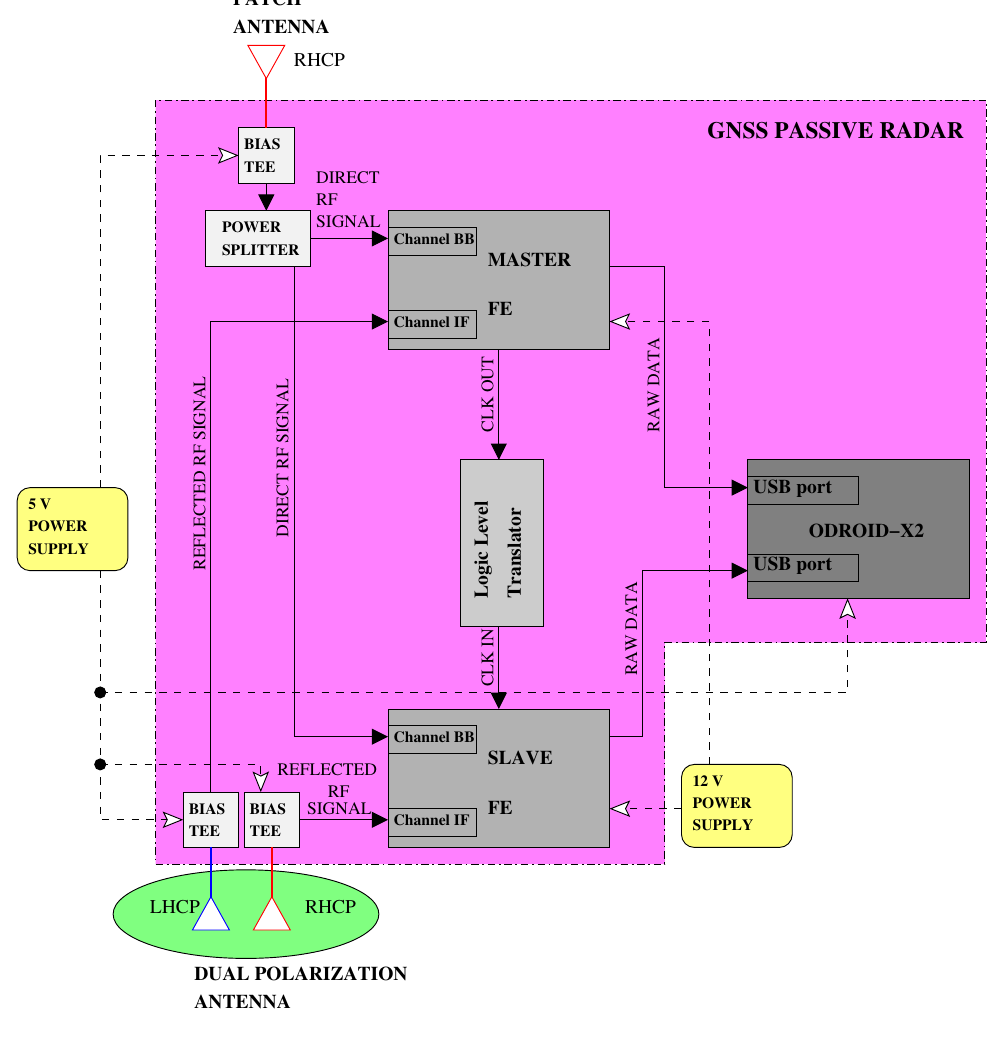
Figure 2. Hardware scheme of the